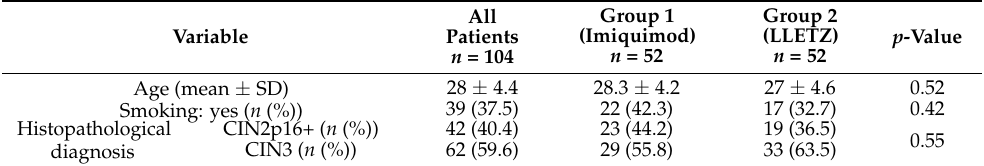
Table 1. Basic patients’